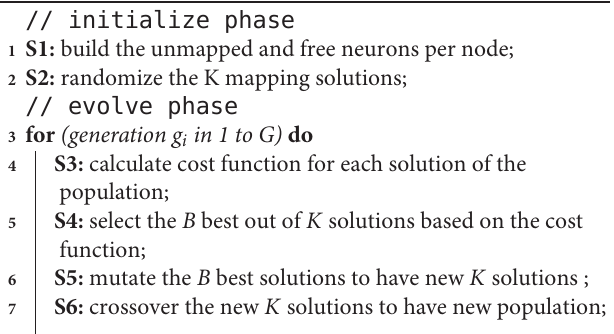
Algorithm 2: Proposed Genetic Algorithm for